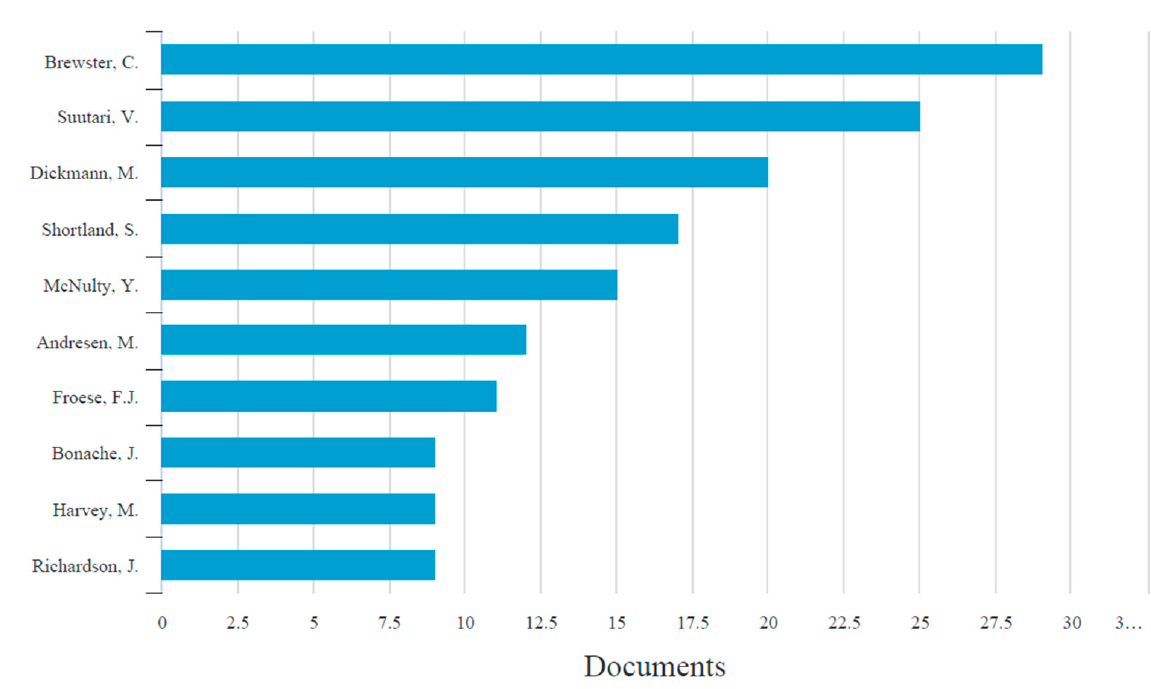
Figure 2. Expatriation documents by author. Source: Data obtained from Scopus (August 2022).